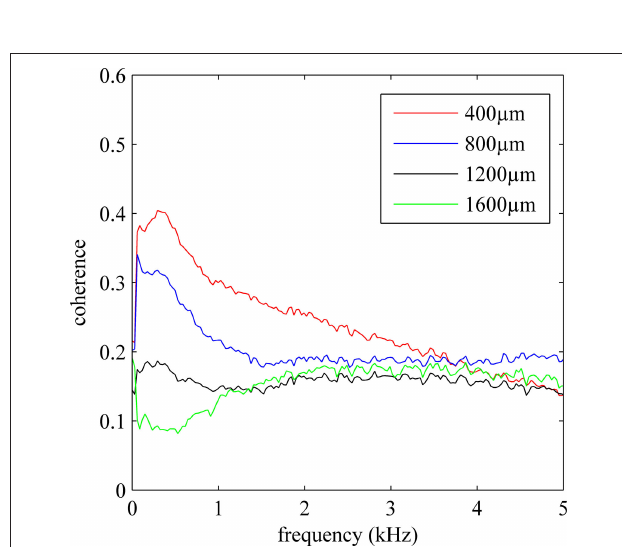
Figure 7 | Average coherence for all possible contact combinations in the electrode array with specific electrode separations of 400 through 1600 μm. Only longitudinal arrangements are considered. Coherence values are averaged across 20 trials from an animal. The average coherence decreases by distance and by frequency in general.